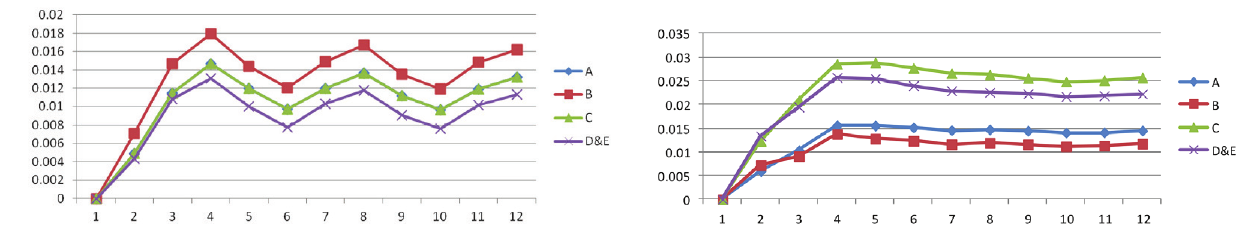
Figure 8d. Accumulated impulse response of PPI to shocks in real GDP